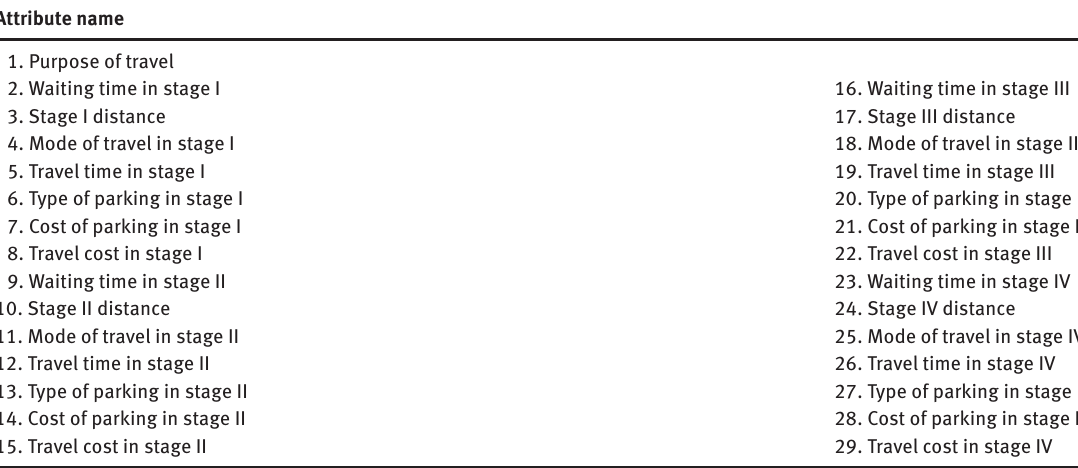
Table 1: Selected Attributes Associated with Every